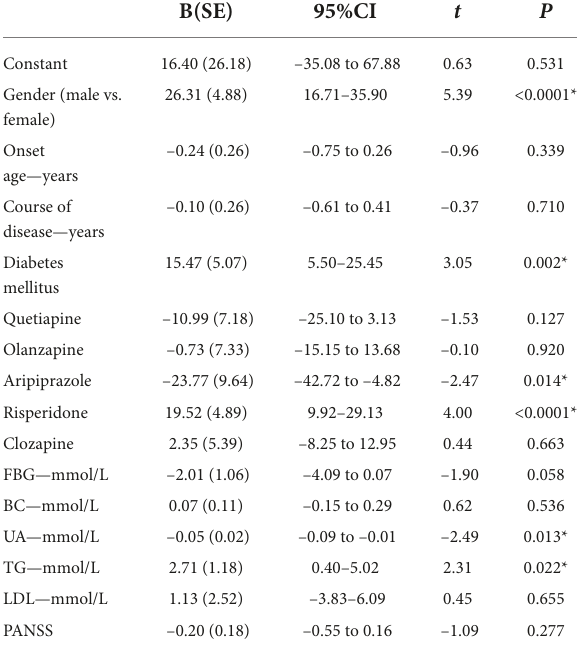
TABLE 3 Influencing factors of prolactin levels: Multiple linear regression model.